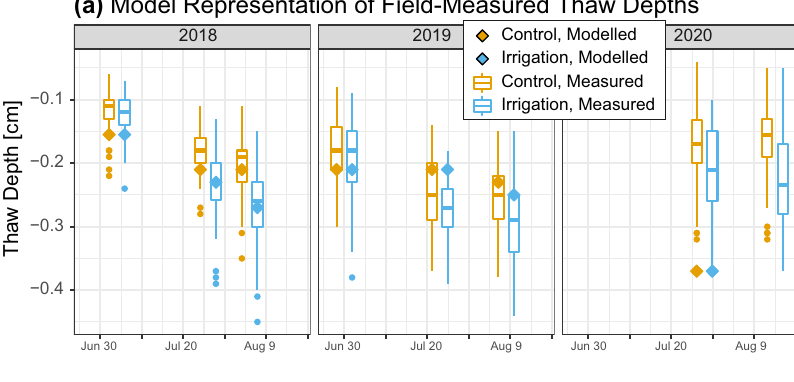
Fig. 1 Results of the irrigation experiment. Abiotic conditions in control (orange) and irrigated (blue) plots during irrigation (2018) and subsequent summers without irrigation (2019 and 2020). The earliest 2018 measurements were taken before irrigation started. a Average daily air temperature and b total daily precipitation recorded in Chokurdakh (WMO station code 21649). c Thaw depth ( n = 90 per violin). d Water table above permafrost in plot centres ( n = 10 per violin). e Volumetric soil moisture content of the topsoil (5 cm depth) ( n = 90 per violin). In c – e , violin length represents data range and violin width represents the probability density of the data distribution. Horizontal bars indicate group medians. Symbols above plots represent signi fi cant Tukey contrasts between irrigation and control per measurement date ( + p < 0.1, * p < 0.05, ** p < 0.01, *** p < 0.001). PS indicates perfect separation (see d ), in which case no p values could be derived. Model speci fi cations and estimated marginal means are in Supplementary Results I.